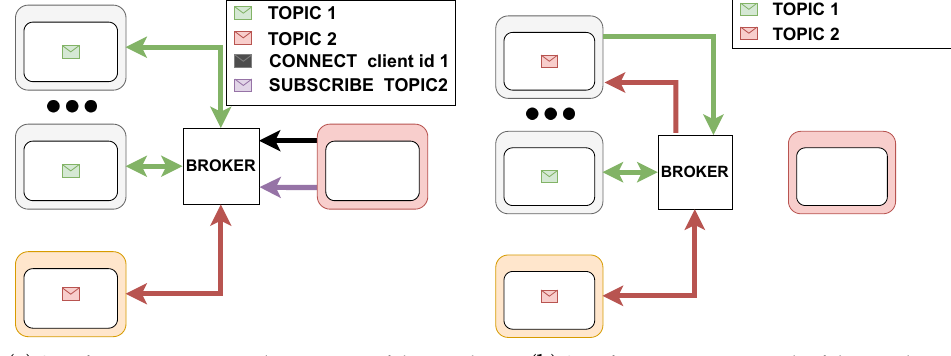
Figure 15. MQTT-SN spoofing connection